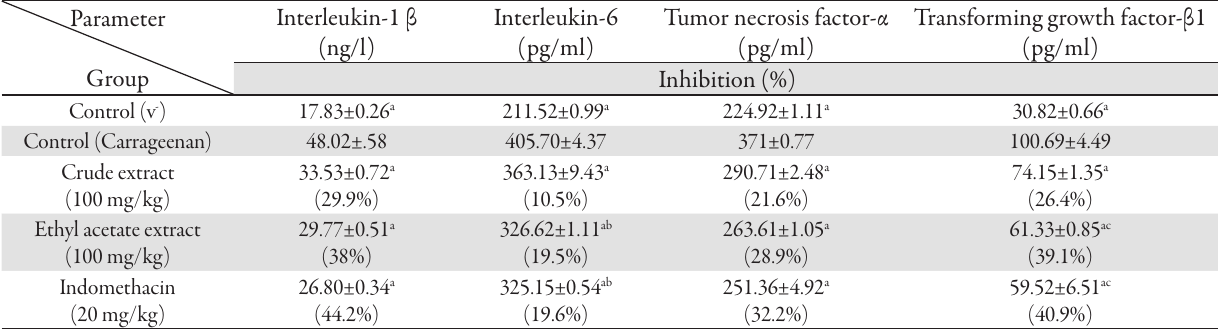
Tab. 2. Effect of S. persica on serum inflammatory cytokines secretion in carrageenan induced paw oedema in rat